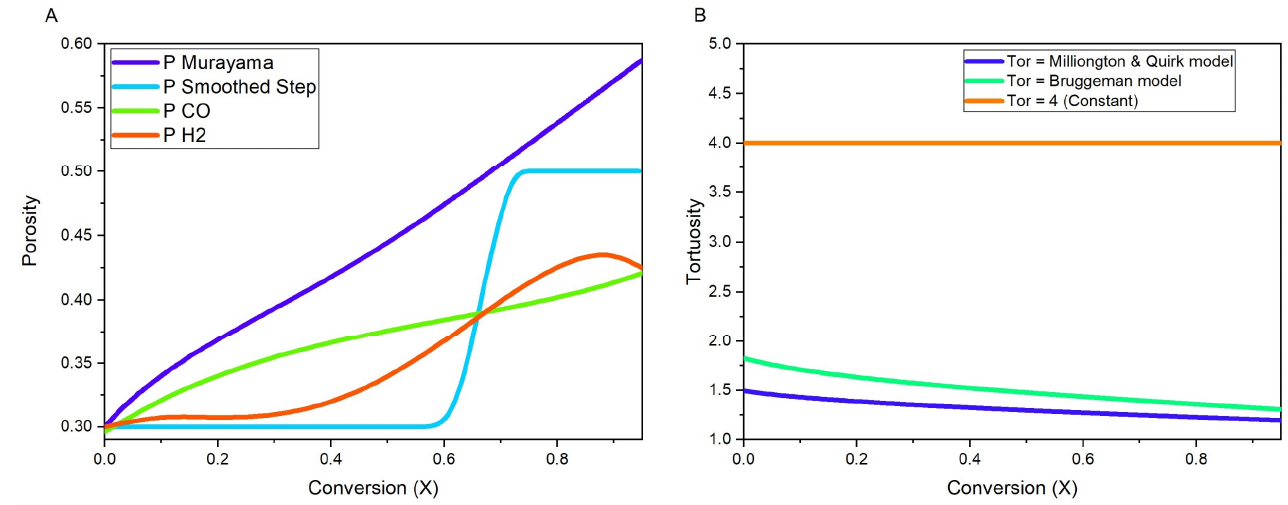
Figure 12. ( A ) Porosity vs. conversion (X) functions used to model the 2D-Axisymmetric model and ( B ) Tortuosity vs. conversion (X) functions used to model the 2D-Axisymmetric